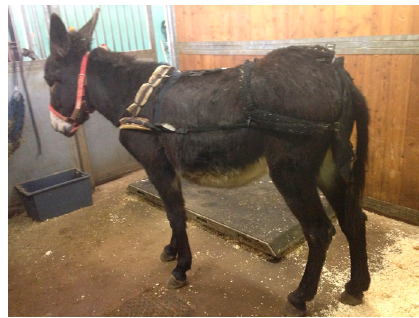
Figure 1. Donkey equipped with an adapted “Steed Apple Catcher”.